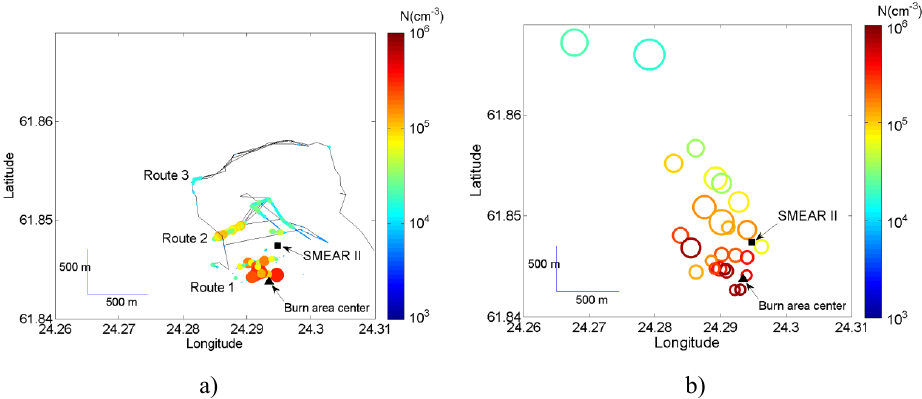
Fig. 14. Horizontal spread of the smoke plume (a) at ground level as observed with the portable CPCs and (b) as observed in the aircraft during flight 1. In (a) both the diameter and the symbol color are scaled according to the concentration. In (b) the color scale is for the concentration and the circle size is scaled according to the diameter of the plume. The concentrations in (a) are all concentrations larger than 10 4 cm − 3 and in (b) the maximum concentrations in the plume crossings.